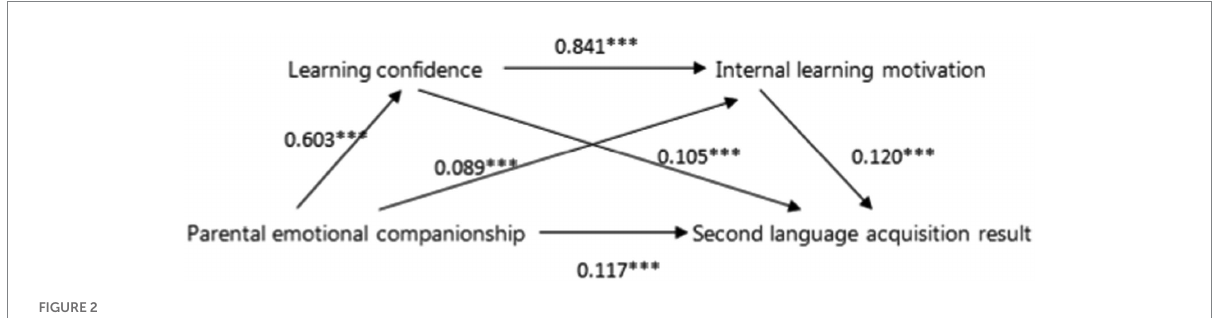
FIGURE 2 Verification result of primary school group theoretical